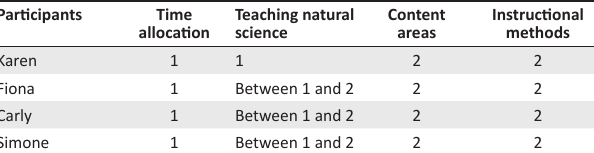
TABLE 5: Summary of the teachers’ levels of interpretation of the natural science curriculum (Levels 1–4). Participants Time Teaching natural Content Instructional allocation science areas